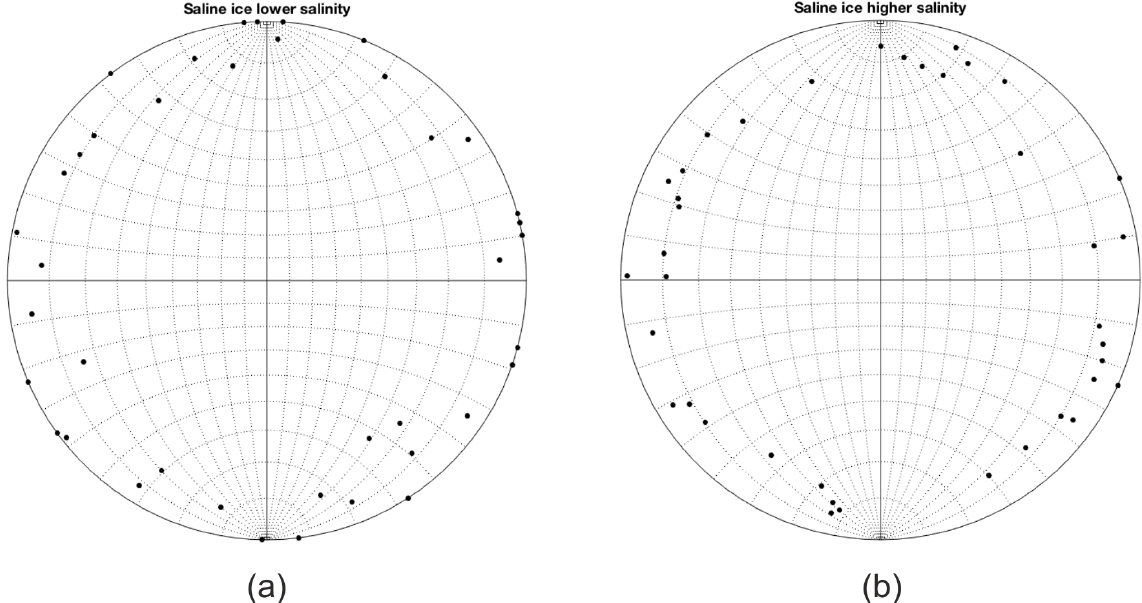
Figure 2. Stereographic projection plots of crystal c -axis {0001} orientations in saline ice of lower (3.0 ± 0.9ppt) salinity (a) and saline ice of higher (5.9 ± 0.6ppt) salinity (b) .